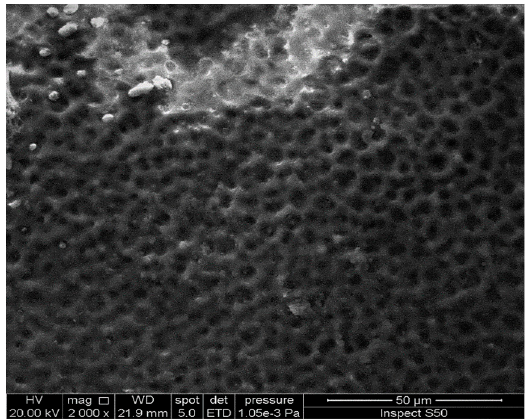
Figure 13. High-resolution SEM image of the PVC film containing complex 3 film after irradiation for 300